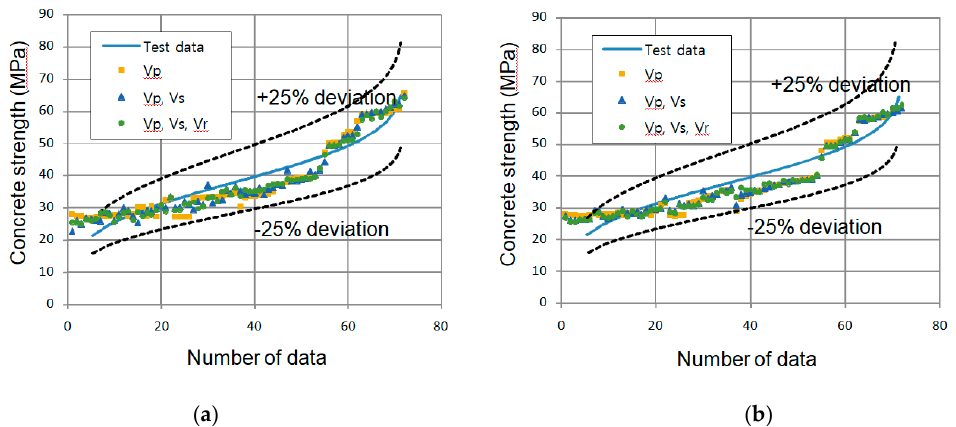
Figure 12. Predicted data distributions by SVM and ANN within a ± 25% deviation from the empirical cumulative distribution curve of the test data. ( a ) SVM; ( b ) ANN.